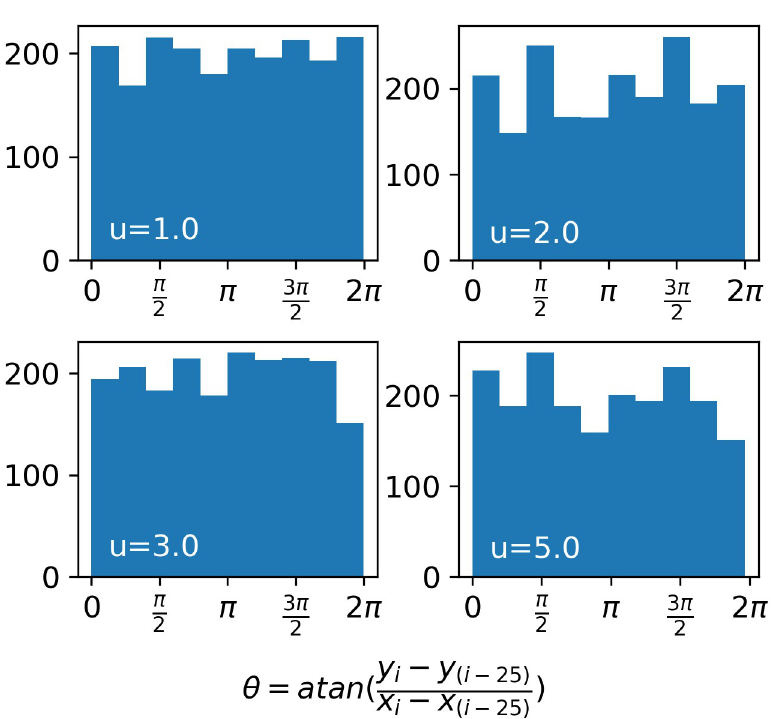
Fig 4. Continuity of θ over consecutive moves. Distributions of direction, θ , for random walks with power-law exponents u = 1.0, 2.0, 3.0, and 5.0, within windows of 25 consecutive moves, over 10 4 moves.